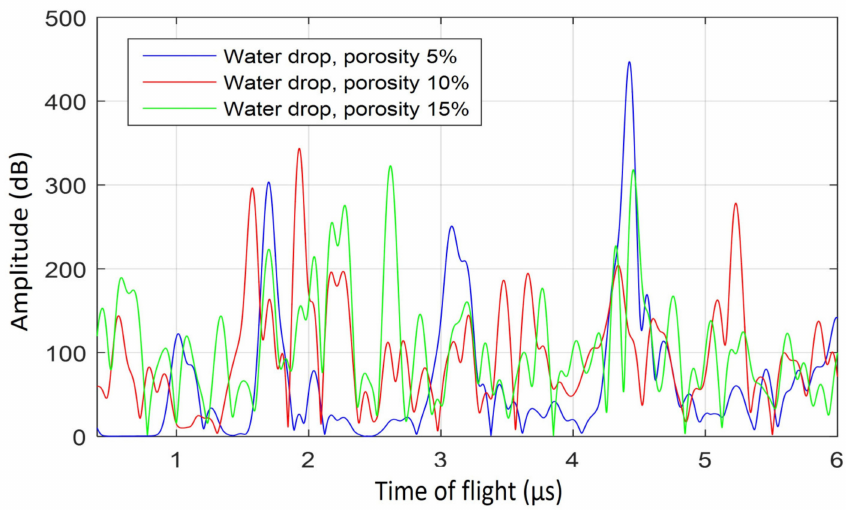
Figure 15. Simulated A-scans of the propagation in a 3 mm liquid water drop. The plots show the response of drops with 5%, 10% and 15% porosity in blue, red, and green, respectively.